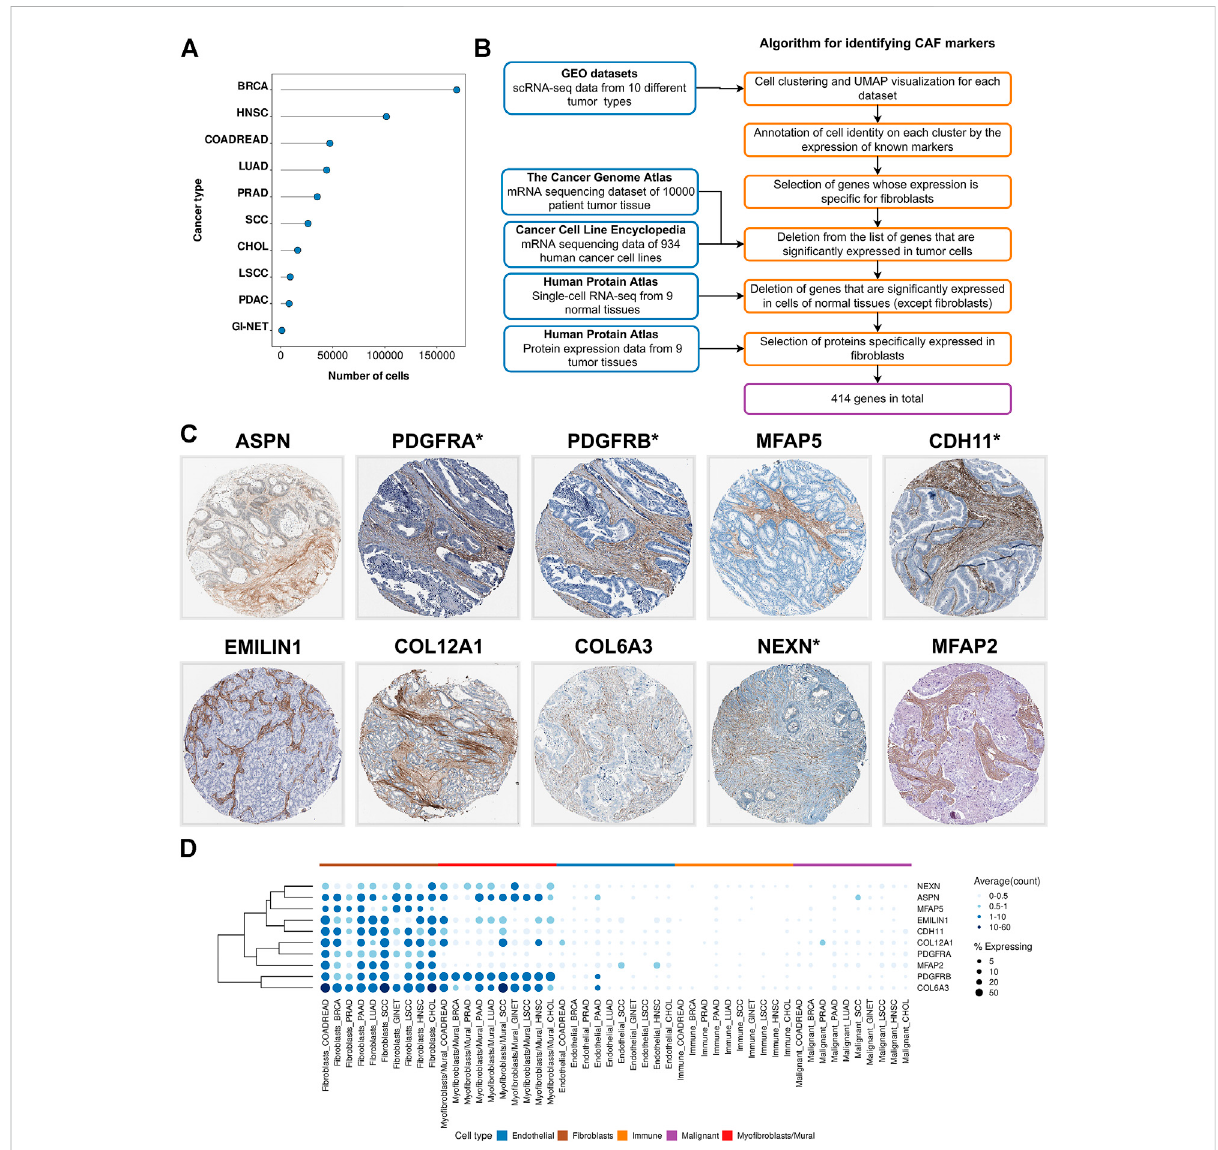
FIGURE 1 Identi fi cation of CAF markers. (A) The total number of analyzed cells in each of the scRNA-seq datasets. (B) Schematics of the study to identify CAF markers. Blue boxes indicate the datasets used in the analysis. Orange boxes indicate the algorithm used to generate signi fi cant gene list. (C) Immunohistochemistry(IHC)stainingimagesshowingproteinexpressionsofASPN,PDGFRA,PDGFRB,MFAP5,CDH11,EMILIN1,COL12A1,COL6A3, NEXN, and MFAP2 in different tumor types from the Human Protein Atlas database. (D) Visualization of CAF marker gene expression across cell type and tumor type. Darker color indicates higher average gene expression from the cells in which the gene was detected, and larger dot diameter indicates that the gene was detected in greater proportion of cells from the cluster. Types of tumor: BRCA — breast cancer, HNSC — head and neck squamous cell carcinoma, COADREAD — colorectal adenocarcinoma, LUAD — lung adenocarcinoma, PRAD — prostate